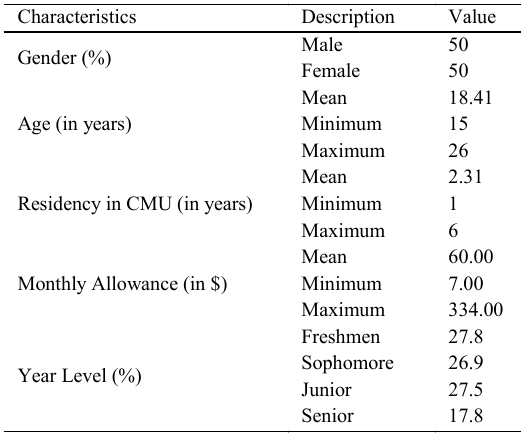
Table 1: Socio-demographic profile of the respondents (N=324)